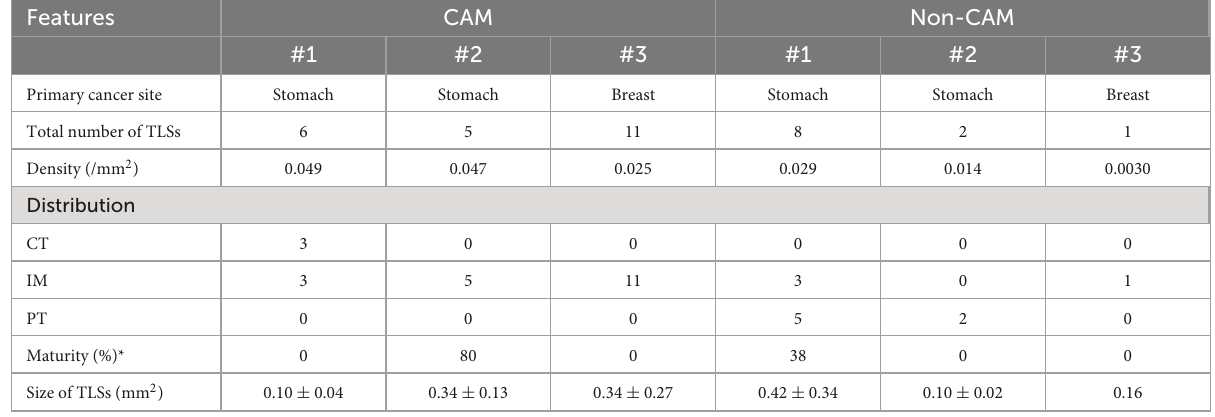
TABLE 2 Histopathological features of TLSs in 3 CAM patients and 3 non-CAM controls.